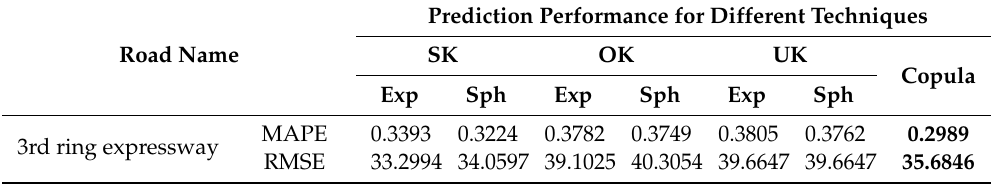
Table 11. Comparison between copula and kriging with MCR at 17:00 on 7 June 2015. Prediction Performance for Different Road Name